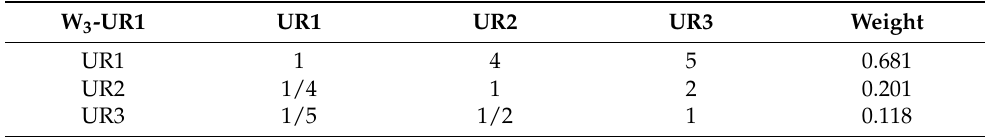
Table A3. Calculating relative weights of URs interms of UR1 through pairwise comparison to determine